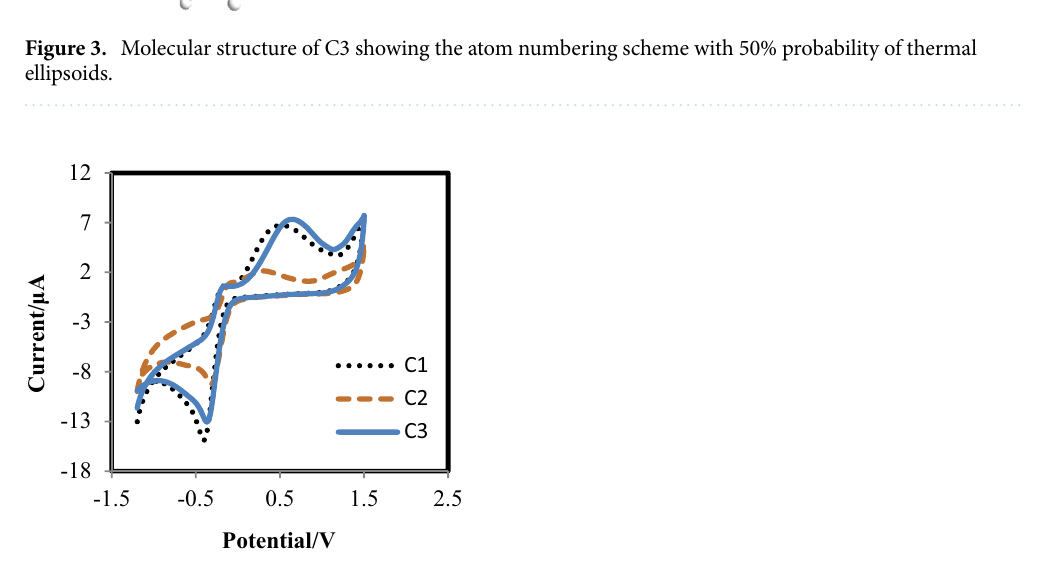
Figure 4. Cyclic voltammogram of complexes c = 4 × 10 –3 mol/dm 3 in H 2 O medium, KCl (0.1 M) at GCE, scan rate 50 V/s.